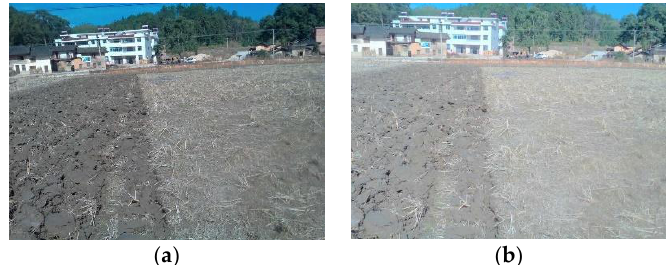
Figure 9. Fields with different illumination strength: ( a ) weak light intensity; ( b ) strong light intensity.